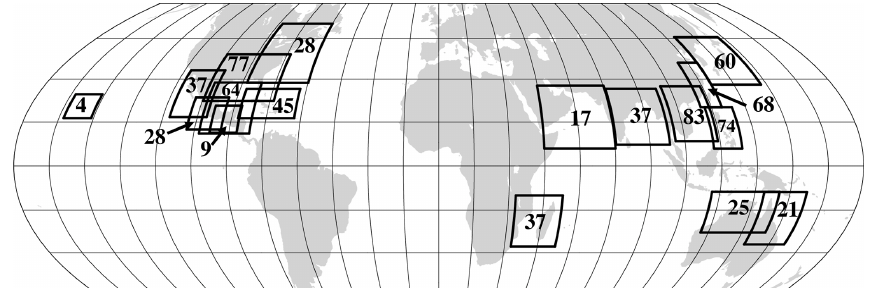
Figure 5. A global map of the 17 simulation domains used in the creation of the dataset of historical global TC footprints. The data record length extends as far back as the required input data are available. Archived R max data extend back to 1988 for the North Atlantic and the eastern Pacific but extend back only as far as the early 2000s for the other basins. The numbers of simulated footprints for each domain are